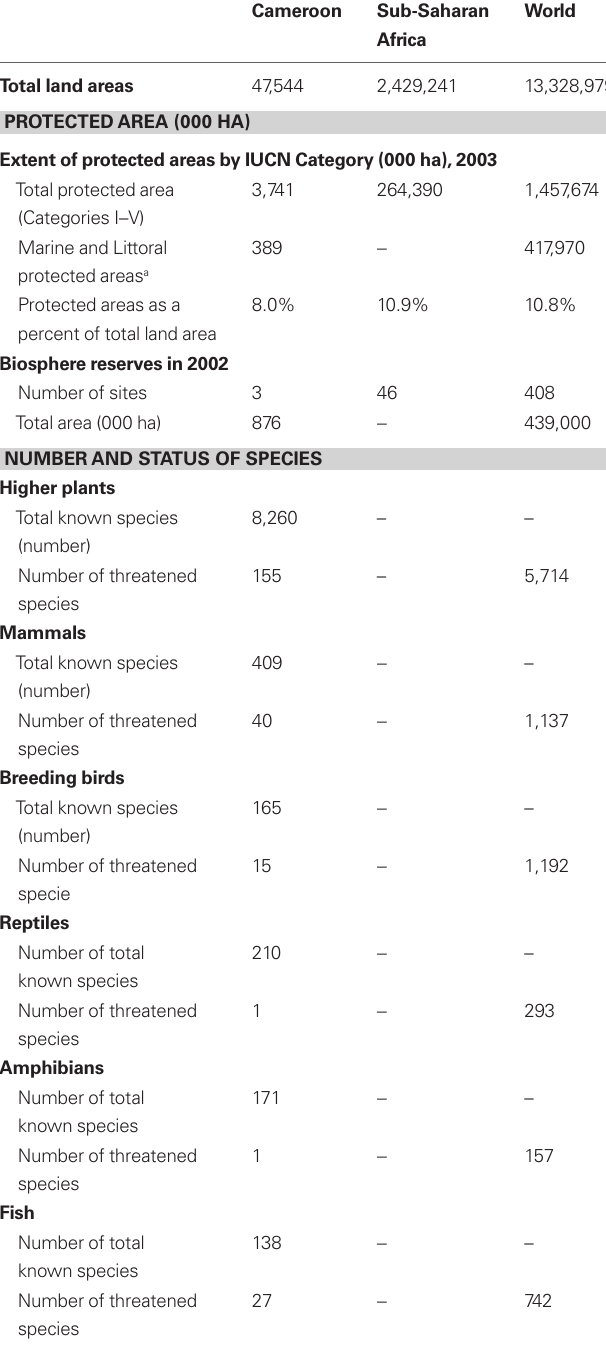
Table 1 | Biodiversity and protected area in Cameroon, Sub-Saharan Africa, and the World (Source: EarthTrends,